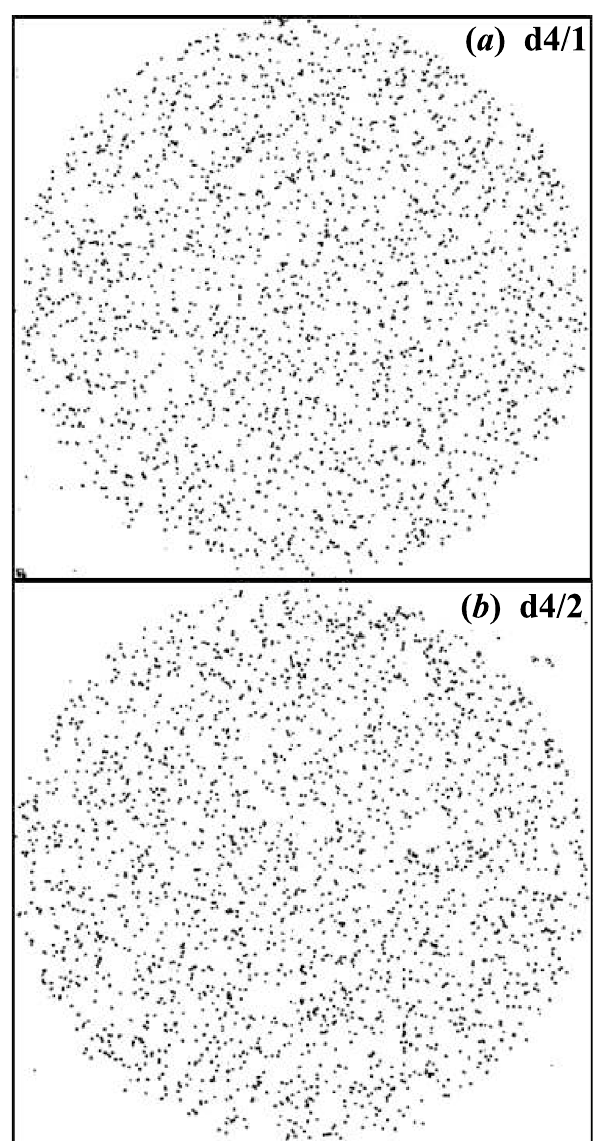
Figure 2. Comparison between the distribution of alpha particles tracks free areas in two photomicrographs ( a ) for sample b4/1 and ( b ) for sample b4/2 of the PADC detector irradiated with 4 MeV alpha particle for 1 min with a time interval of 10 min, samples were chemically etched in 6.25 N NaOH at 70 ◦ C for 4 h. The area of 2 each picture is 1583 1583 µ m ×